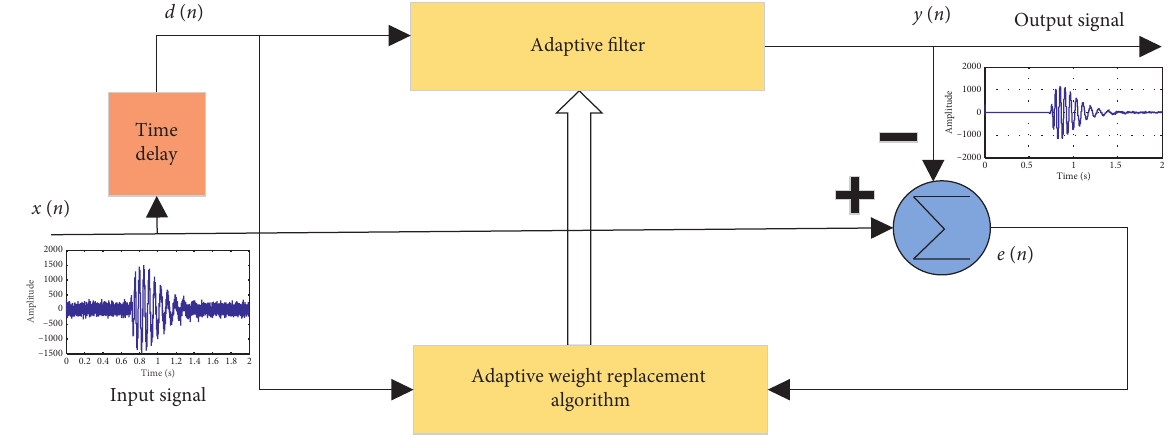
Figure 3: D-LMS filter model